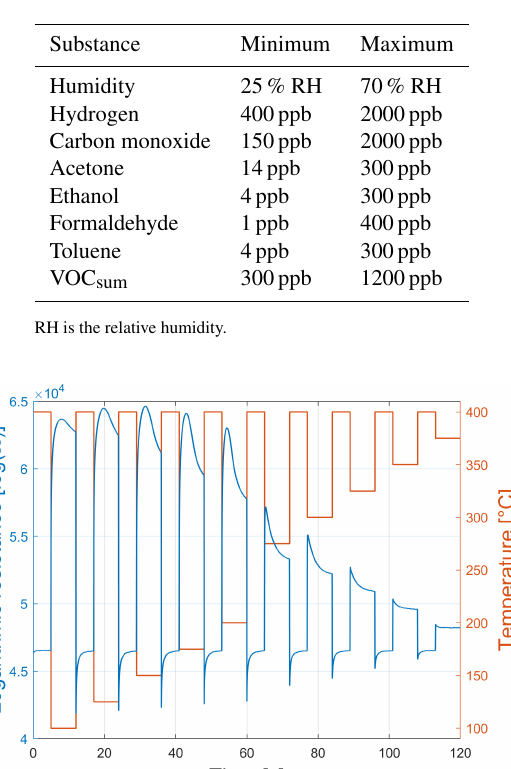
Table 1. Concentration ranges for all gases during the initial cali- bration phase (Amann et al., 2021b).